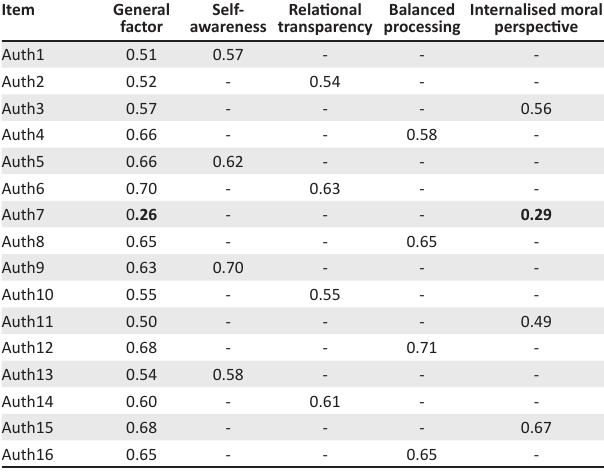
TABLE 4: Standardised factor loadings for the bi-factor (Authentic Leadership Inventory, N = 213).